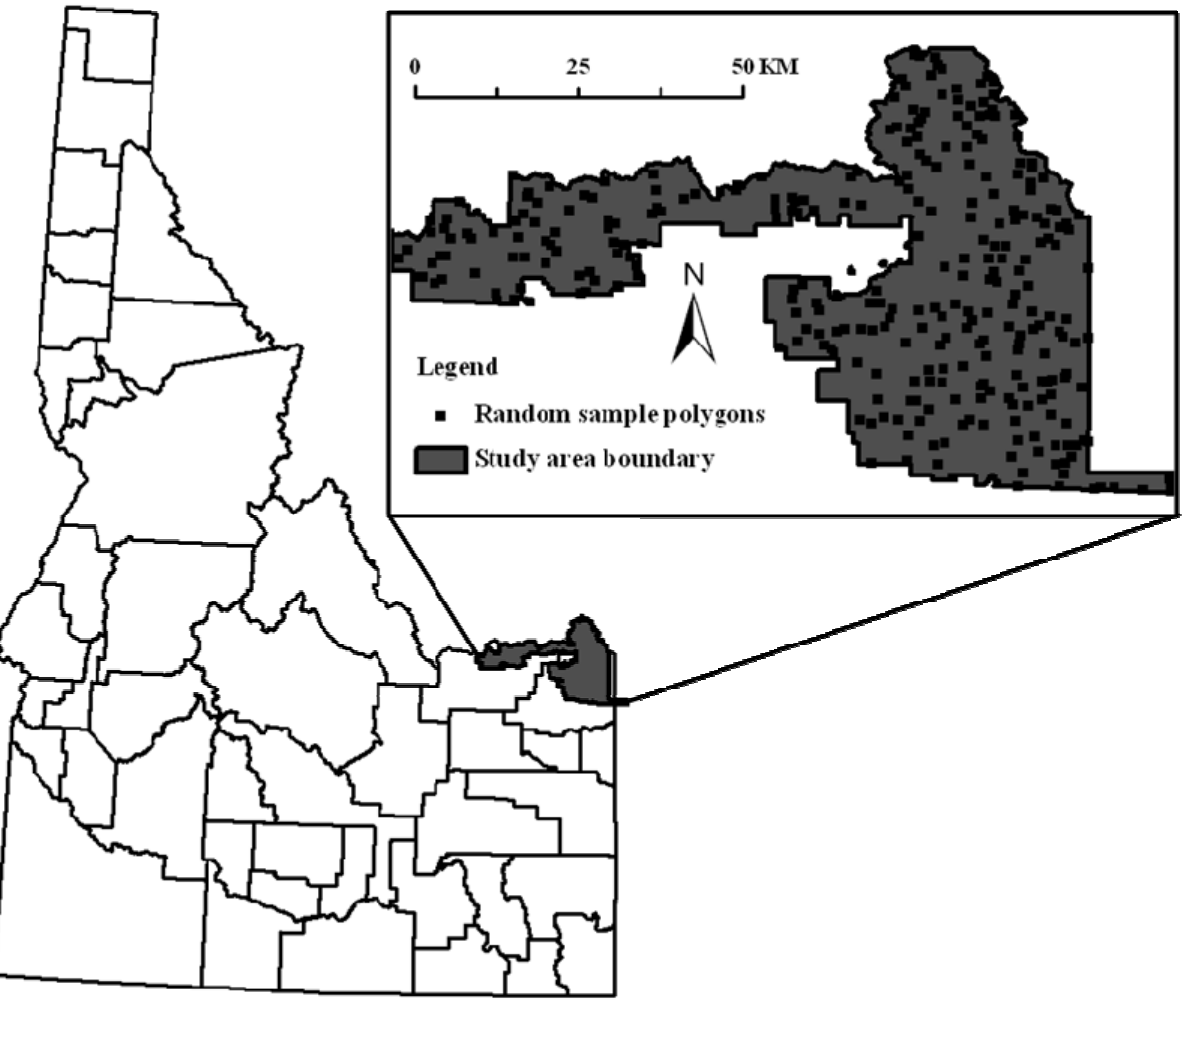
Figure 1. Study area and 300 randomly-generated sample polygon locations in the Targhee National Forest in Idaho,